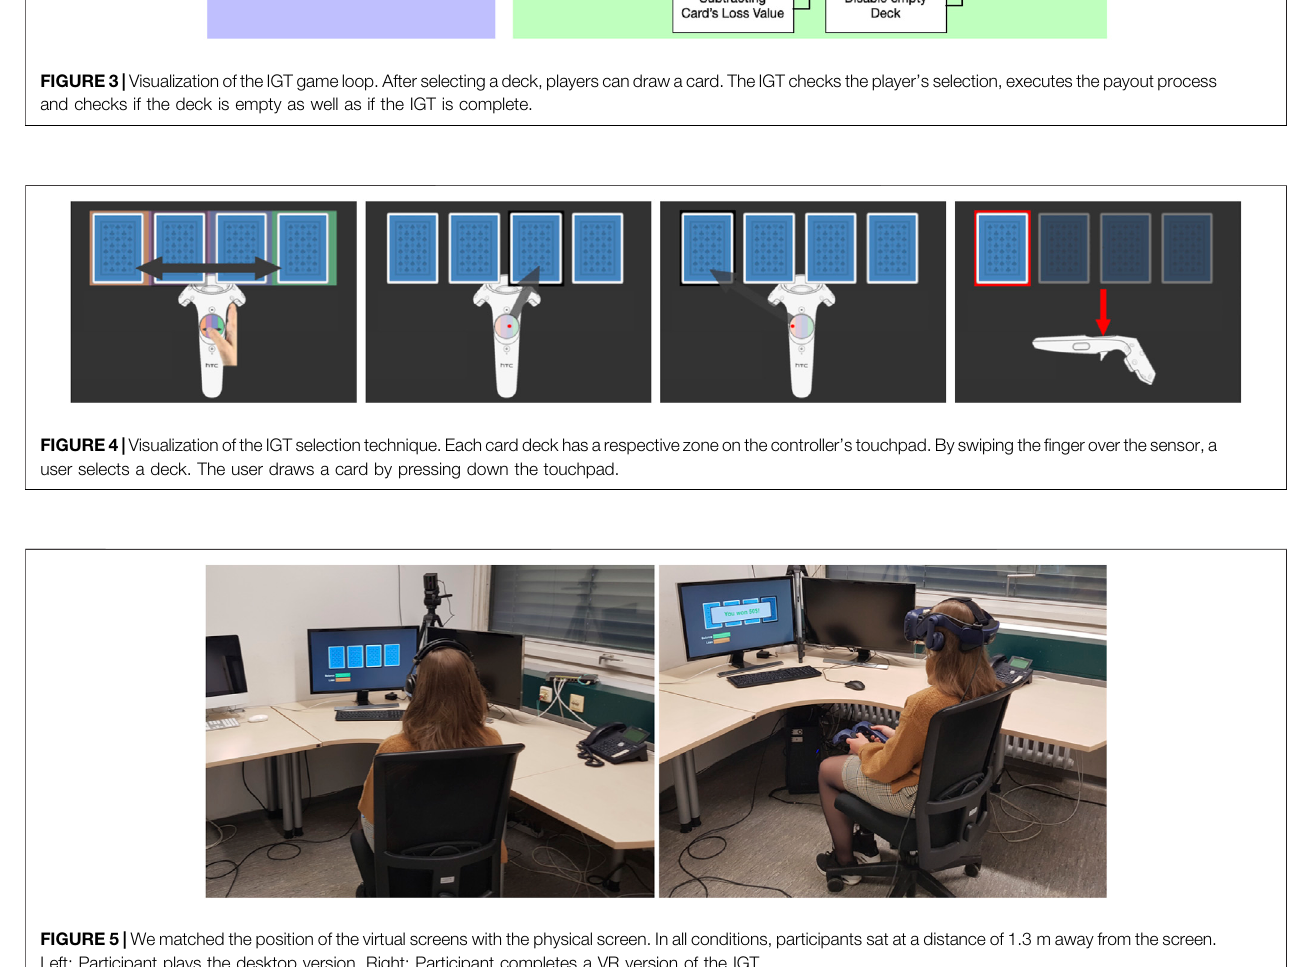
Frontiers in Virtual Reality |